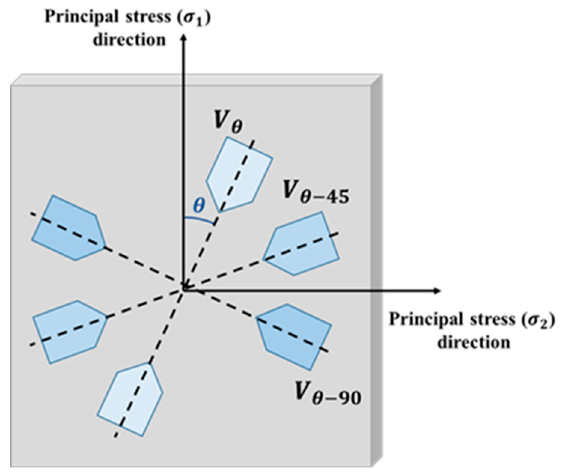
Figure 1. Schematic of the relationships of the angles between the principal stress direction and three-measuring directions in 45 ◦ increments, in which θ is the angle from a measuring direction to the principal stress ( σ 1 ) direction, and V θ , V θ − 45 , V θ − 90 are surface wave velocities propagating in the θ , θ − 45 ◦ , and θ − 90 ◦ directions,